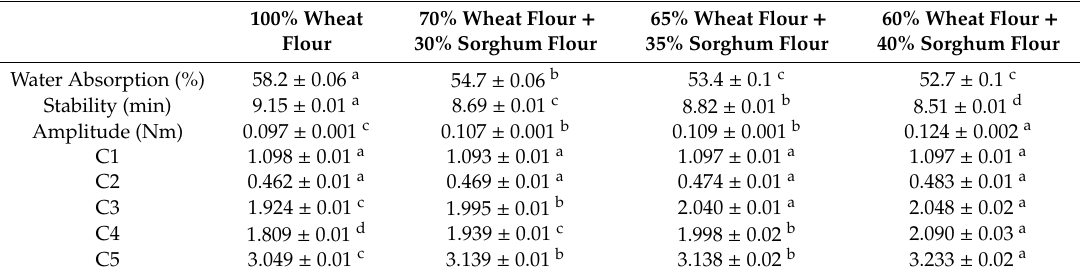
Table 6. Rheological characteristics of flour mixtures and wheat